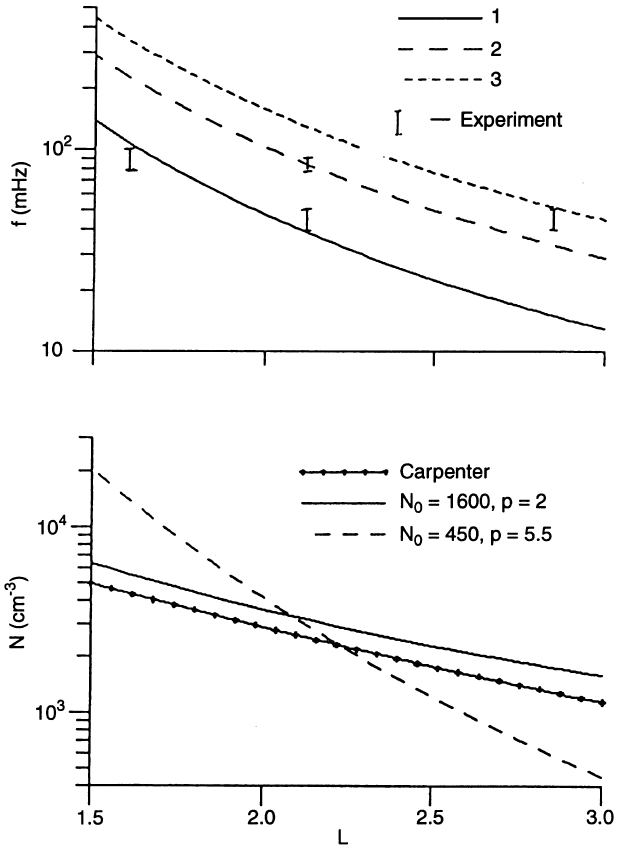
Fig. 14. Radial profile of latitude-dependent resonant frequencies approximating the experimental data ( dashes ) from the meridional network. Solid line corresponds to calculated frequencies of the fundamental mode, dashed lines – of 2-nd and 3-d harmonics